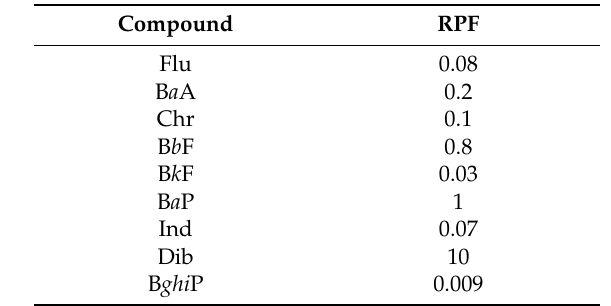
Table 2. Relative potency factor (RPF) values of individual polycyclic aromatic hydrocarbons (PAHs) included in the inhalation cancer risk assessment